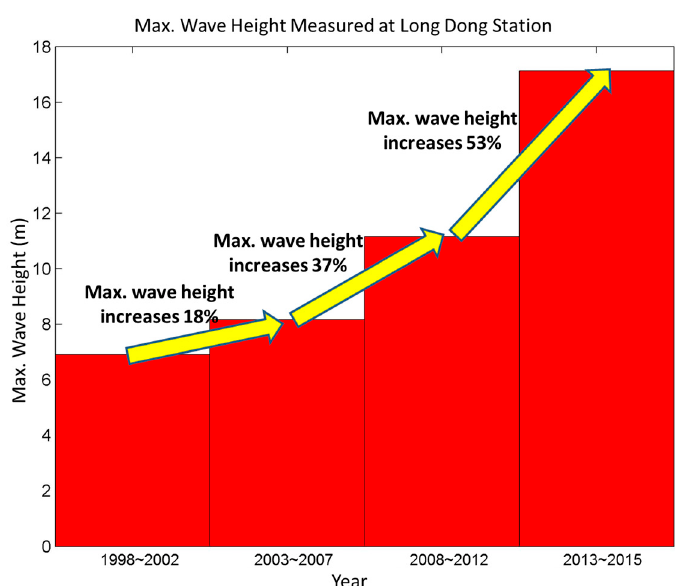
Figure 2. Increasing trend of maximum wave height measured at Long Dong station located at the northeast coast of Taiwan.